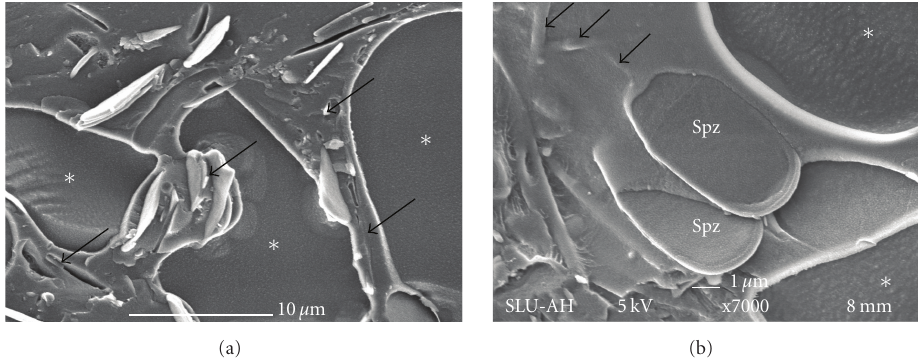
Figure 1: Cryo-Scanning Electron microscopy (Cryo-SEM) micrographs of boar semen conventionally frozen in Flat-Pack, showing the frozen extender (arrows), containing spermatozoa (spz and small arrows) and the areas of frozen free water ( ∗ = lakes), Bars: (a) 10 μ m, (b)1 μ m (Photo: H Ekwall,